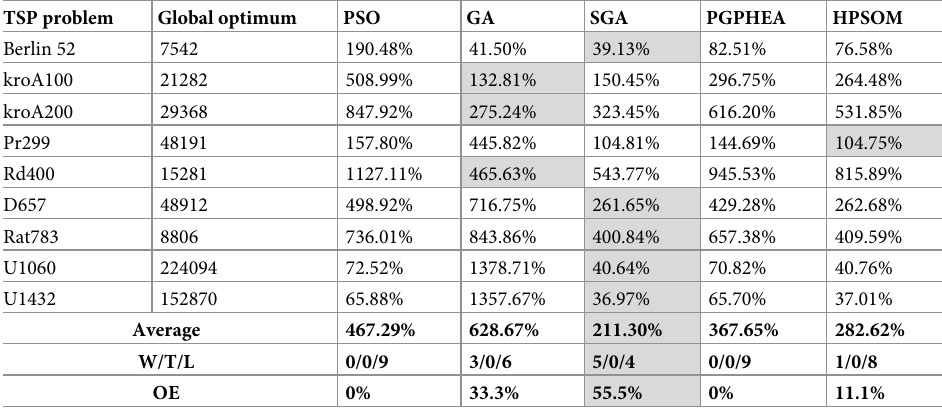
Table 11. Comparison of average relative distance error for traveling salesman problems.